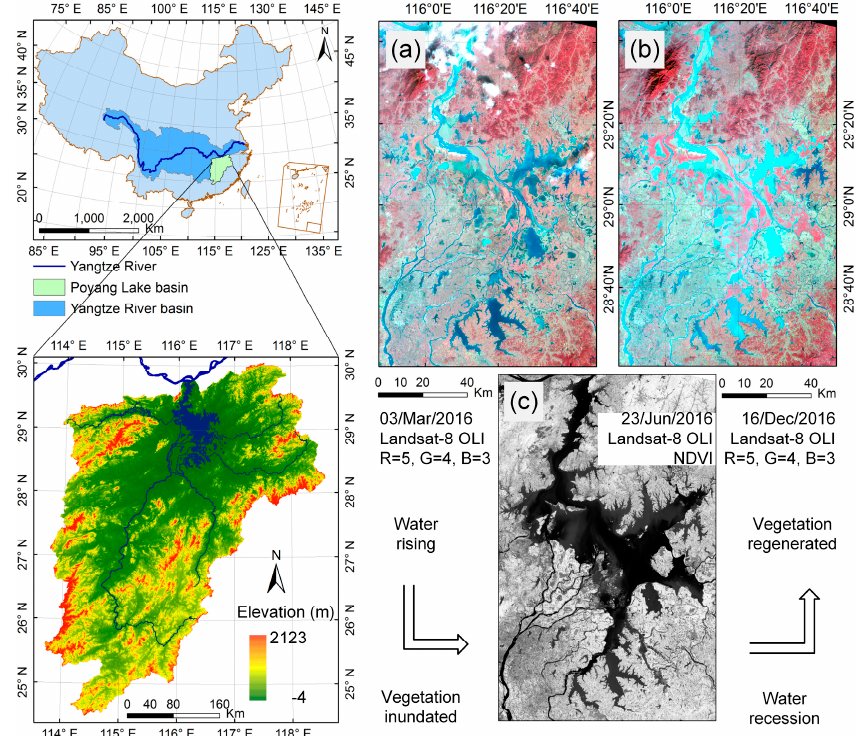
Figure 1. Location of the Poyang Lake. Landsat-8 Operational Land Imager (OLI) images show water surfaces at the lake surface expanding ( a ) and shrinking ( b ) period. Vegetation is gradually inundated at the lake surface expanding period and is regenerated at the lake surface shrinking period. The Landsat-8 OLI Normalized Di ff erence Vegetation Index (NDVI) image ( c ) shows contrasting spectral behaviors between the water surface and vegetation at a high water stage.